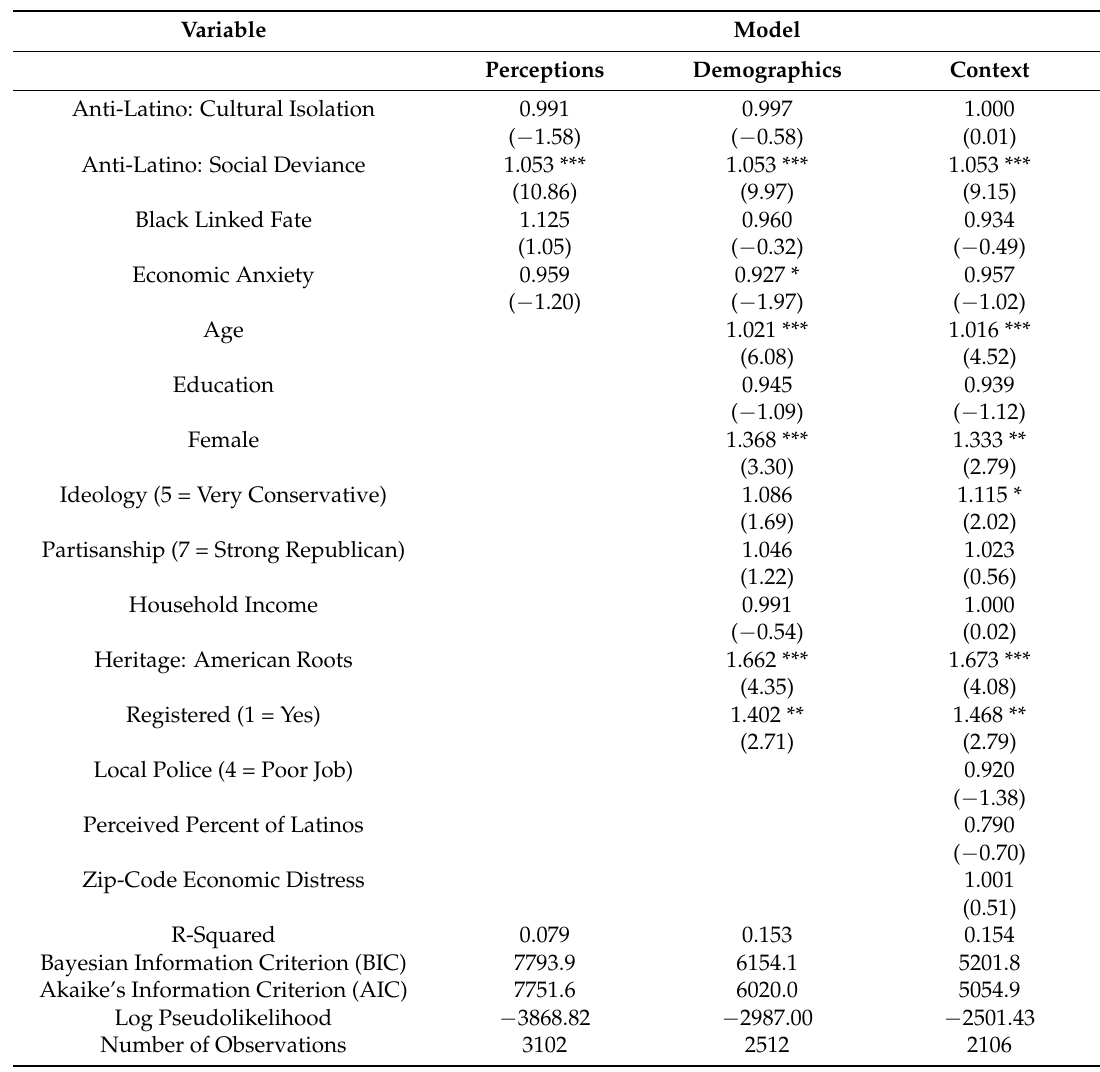
Table 2. Odds ratios from the ordinal logistic models of support for deporting immigrants who break the law by anti-Latino perceptions, demographics, and registration